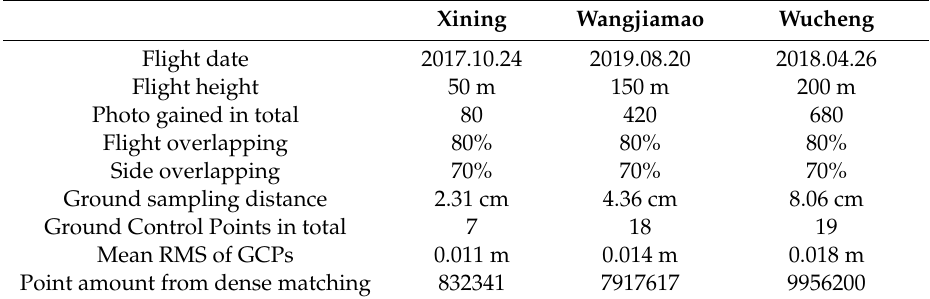
Table 2. Unmanned aerial vehicle (UAV) flight information of three study